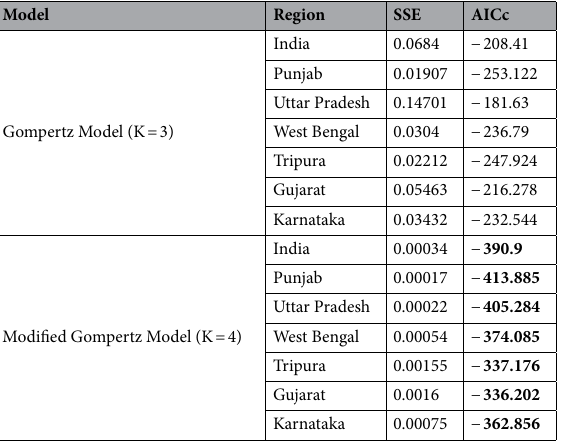
Table 3. Minimized sum of square (SSE) and AICc values under Gompertz Model and Modified Gompertz model for India and the 6 selected states. The least value of AICc is written in the bold case for each state.